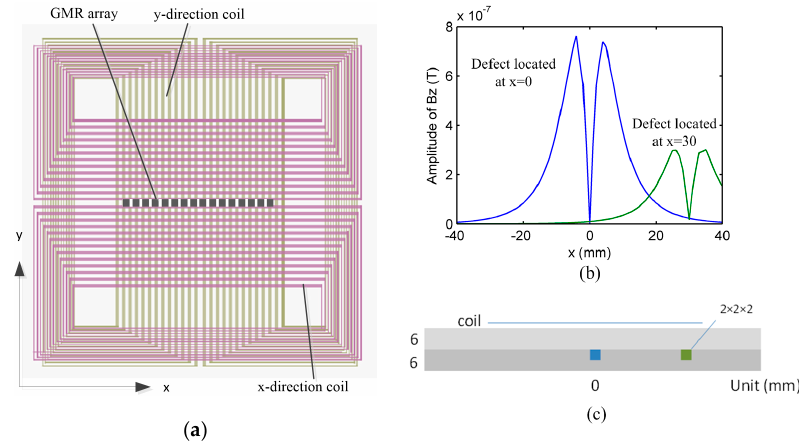
Figure 1. ( a ) Top view of orthogonal coils and linear array sensors; ( b ) Simulation result of response signals due to defect located at x = 0 mm and x = 30 mm; ( c ) Lateral view of the model. The eddy current density at the center of the sensor array is higher in magnitude compared to located under the sensor at the center is detected with a stronger response compared to the signal produced at the sensor when the defect is located near the coil edge at same depth. The 1D scan